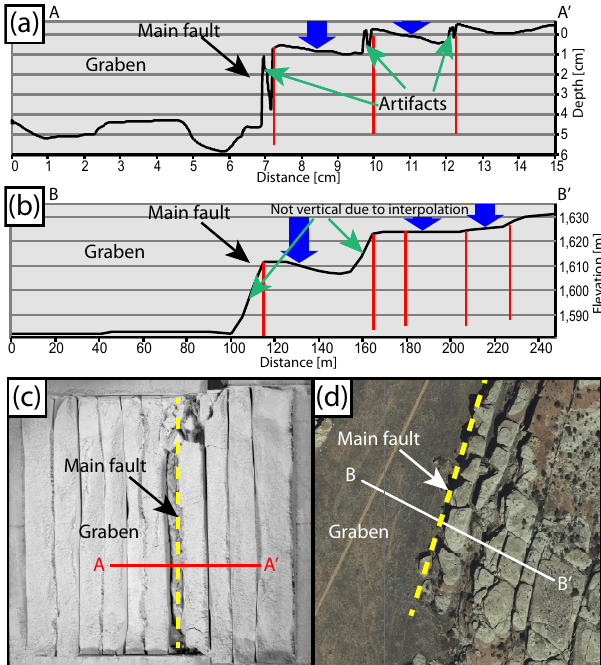
Figure 15. Comparison of elevation profiles from experiment (a) and nature (b) . Both show typical stair step geometry caused by incremental reactivation of joints by fault migration from foot- wall to hanging wall. Location of the profiles shown in (c) and (d) for experiment and nature, respectively. Location of (d) marked in Fig. 14a by red star. Sharp spikes in elevation in a are artifacts of photogrammetric 3-D reconstruction caused by shadows in open gaps. Inclined slopes in (b) instead of vertical surfaces result from interpolation of the elevation model. In reality these are vertical joint surfaces (cf. Kettermann et al.,